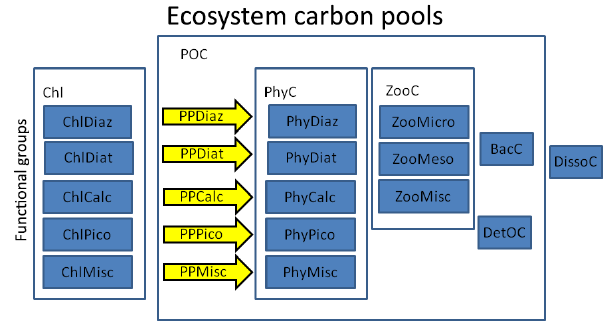
Figure 14. Ocean ecosystem carbon pools in terms of chlorophyll- based and carbon-based phytoplankton functional groups, zoo- plankton size groups, bacteria, detritus, and dissolved organic car- bon. As with land carbon diagnostics, the tier-2 requests are sub- components of the tier-1 aggregate quantities. For example, ZooC should report the total carbon pool in zooplankton. The sum of the tier-2 components ZooMicro, ZooMeso and ZooMisc should be identical to the tier-1 total. They are not additional pools to it.